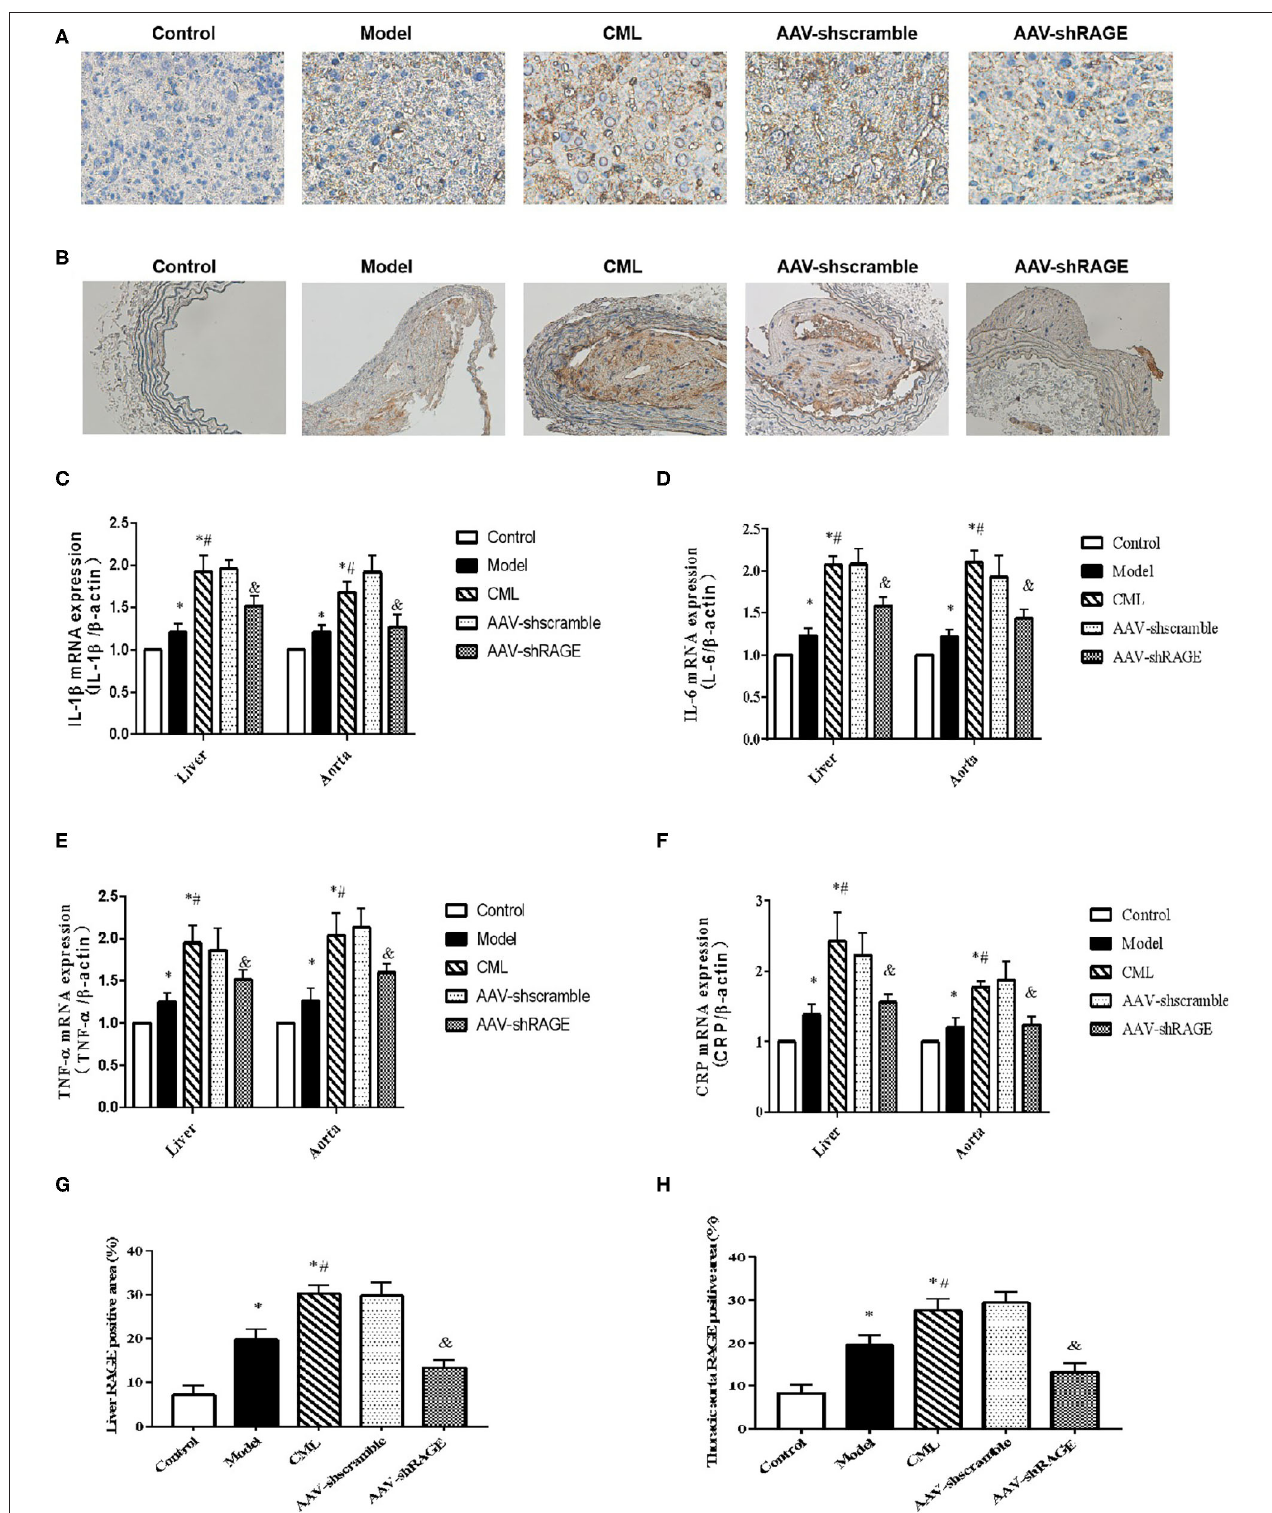
FIGURE 8 | After AAV injection, the expression of RAGE in liver and aorta changed (A) and (B) Immunohistochemistry shows the expression of RAGE ( × 400). (C–F) Detection of IL-1 β , IL-6, TNF- α , CRP mRNA expression levels in liver and aorta by PCR (G,H) Percentage of RAGE positive immunohistochemical staining area. The proportion of the positive area to the total Liver area was calculated by ImageJ. * P < 0.05, compared with normal control group; # P < 0.05, compared with model group; & P < 0.05, compared with CML group.